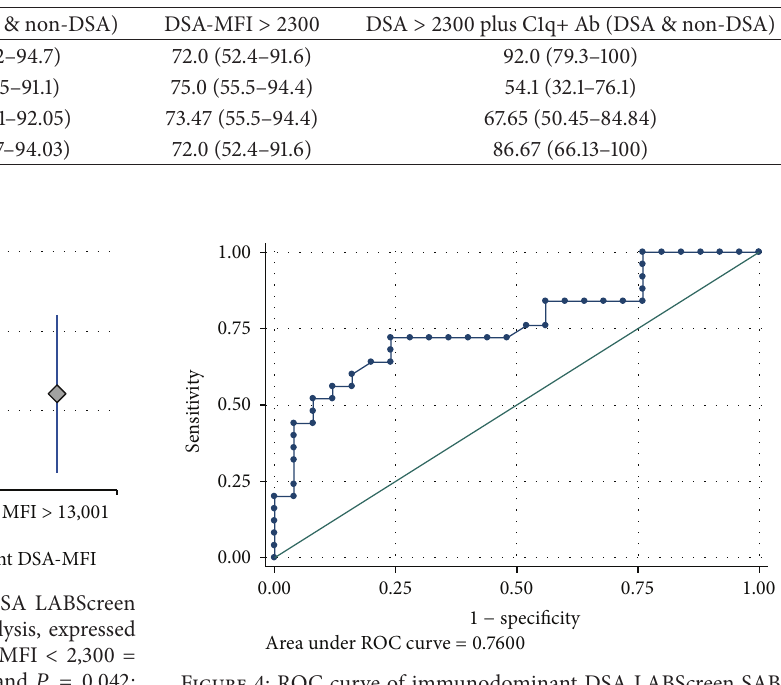
Figure 4: ROC curve of immunodominant DSA LABScreen SAB MFI and FXM. MFI > 2,300 showed the best